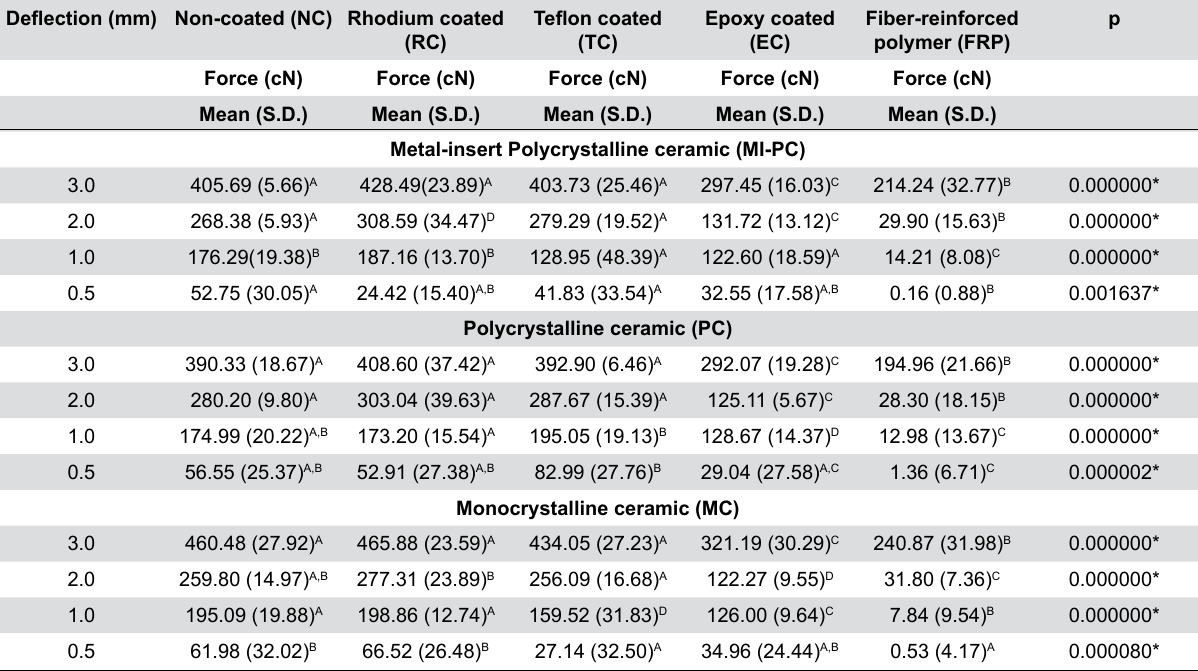
Table 2- Deflection forces (cN) comparison of the different archwires inserted in MI-PC, PC and MC brackets